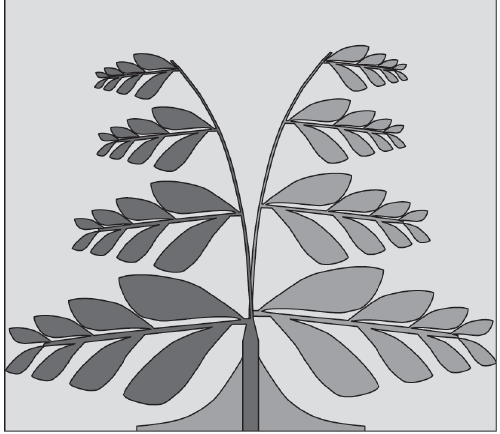
Figure 7. Fen leaf inspired fractal AVA for microwave imaging applications (redrawn from [56]). Dark gray top metal face, medium gray bottom metal face, and light gray dielectric substrate.